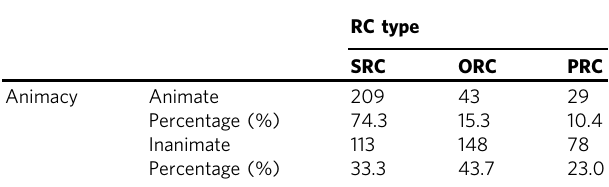
Table 2 Frequencies and percentages for SRCs and ORCs with animate and inanimate head nouns.